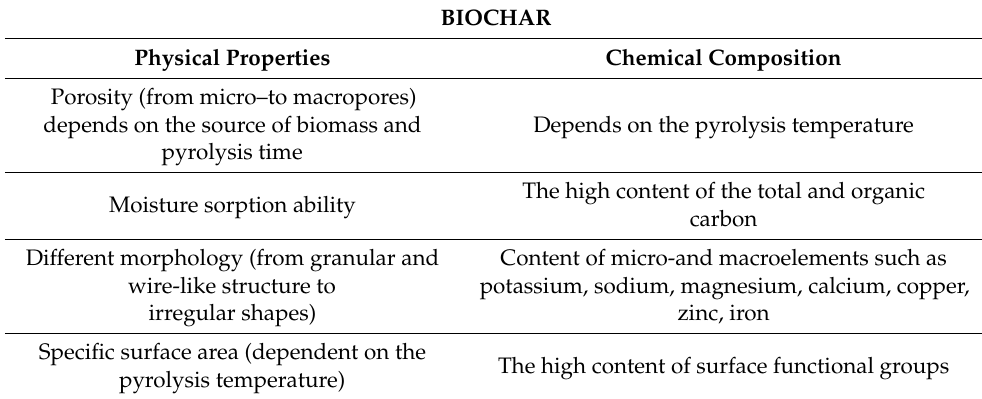
Table 2. Features influencing physicochemical properties of biochar, based on